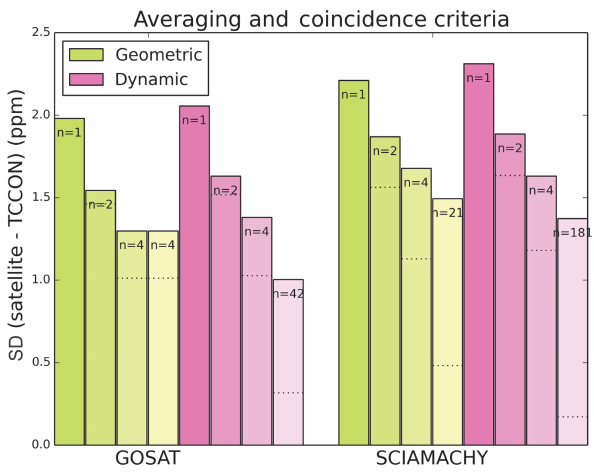
Figure 5. Standard deviation of SCIAMACHY and GOSAT minus TCCON for different coincidence criteria and number of satellite observations averaged, n , in the Northern Hemisphere. The follow- ing consistent set of stations was used for all comparisons: Bia- lystok, Karlsruhe, Orléans, Garmisch, Park Falls, and Lamont. The dotted line shows the error if it scaled as the inverse square root of the number of averaged observations. The far right case for each of the categories contains the maximum n that has results for all